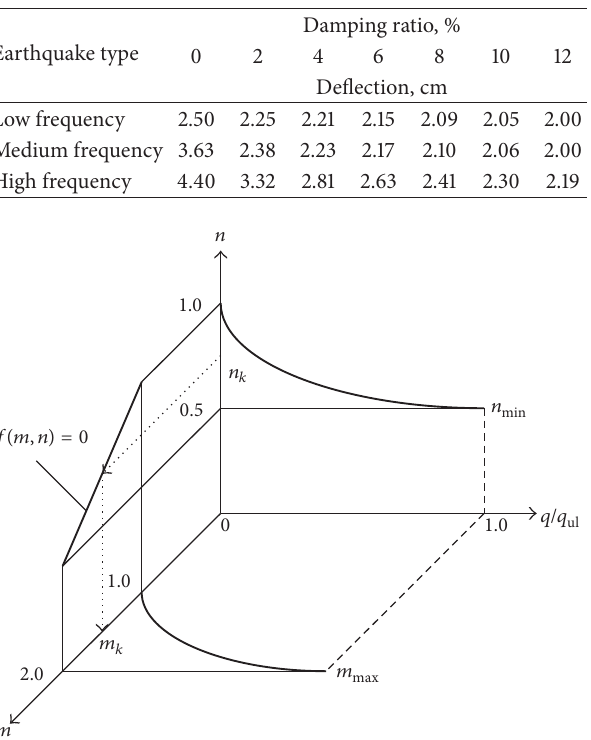
Table 1: Deflections in a fill scale RC shell versus damping ratios.